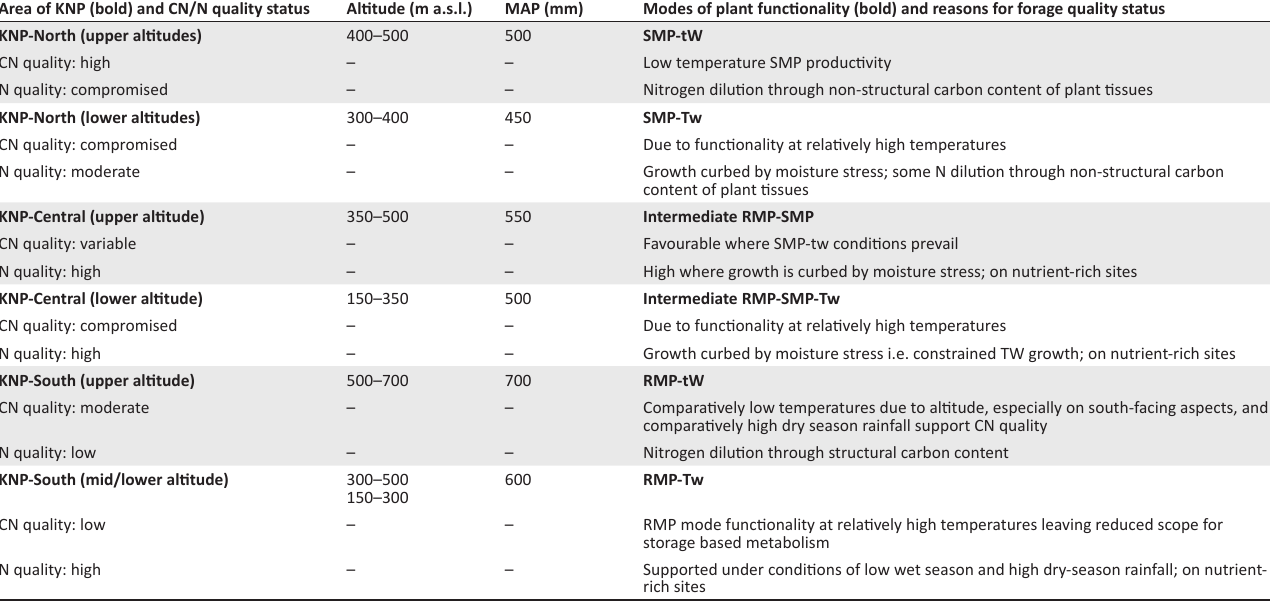
TABLE 1: Plant functionality settings according to prevailing environmental conditions in various parts of the Kruger National Park and their expected consequences for forage quality (climate–vegetation response model). Area of KNP (bold) and CN/N quality status Altitude (m